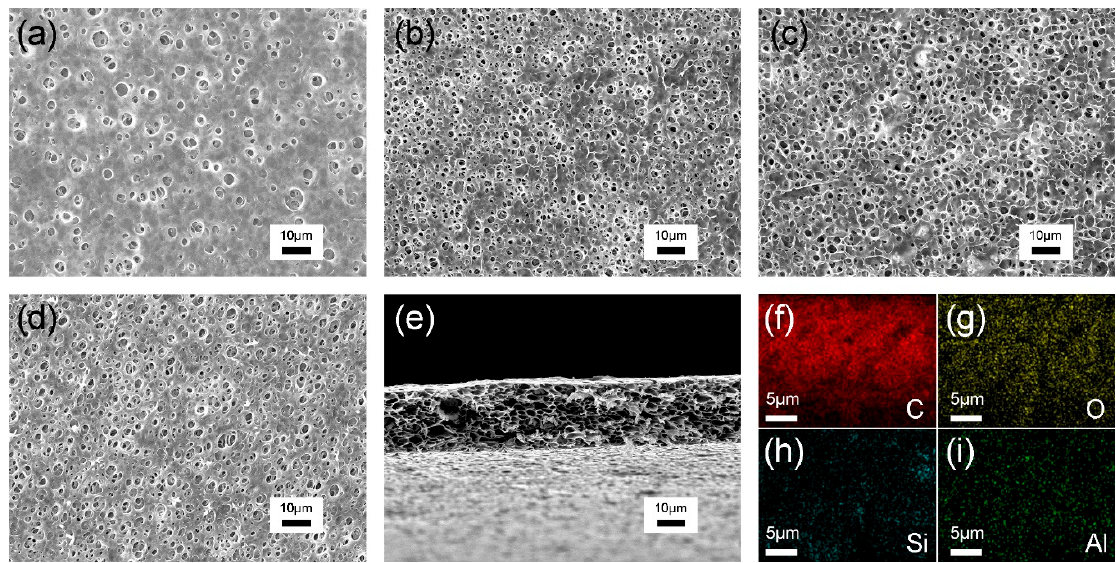
Figure 2. SEM micrographs for the surface of PI separators and composite separator with different ZSM-5 concentrations: ( a ) PI, ( b ) Z / PI-5, ( c ) Z / PI-10, and ( d ) Z / PI-15. ( e ) SEM micrographs for the cross-section of Z/PI-10 composite separator. (f–i) Elemental mapping of Z/PI-10 composite separator.